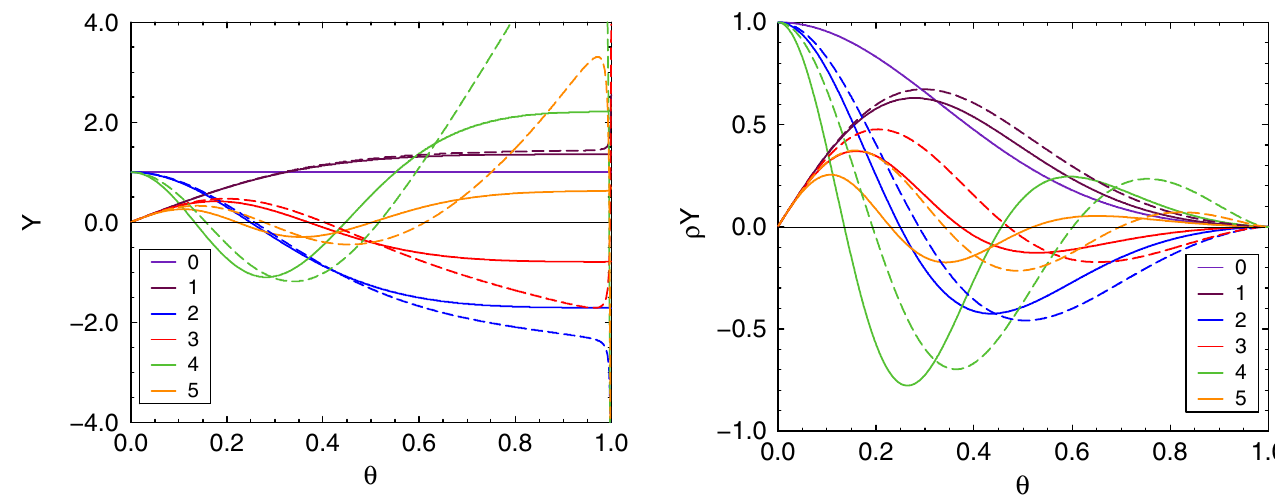
FIG. 6. (Color) Eigenfunctions of the Gaussian bunch at (cid:10) ¼ 1 = 3 and low (cid:7) . Solid lines: (cid:7) ¼ 0 : 01 ; dashed ones: (cid:7) ¼ 0 : 2 .